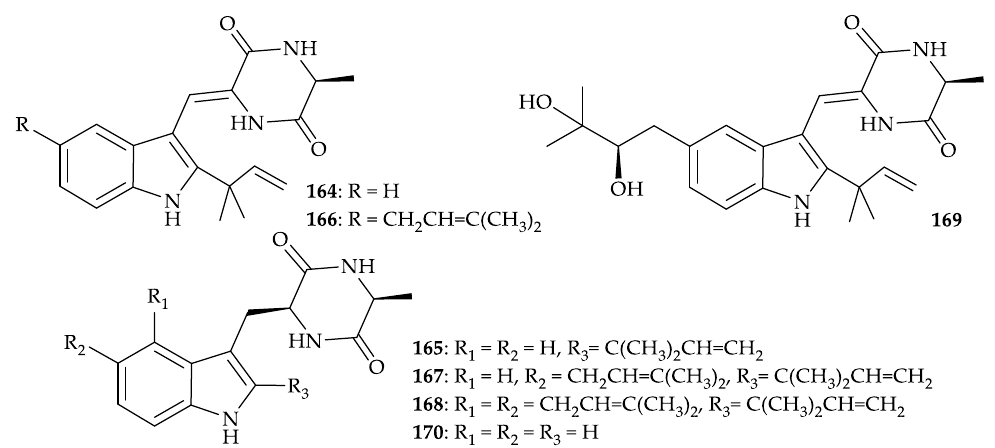
Figure 27. Structures of neoechinulin A ( 164 ), preechinulin ( 165 ), isoechinulin A ( 166 ), tardioxopiperazine A ( 167 ), variecolorin L ( 168 ), dihydroxyisoechinulin A ( 169 ), and L-alanyl-L- tryptophan anhydride ( 170 ).